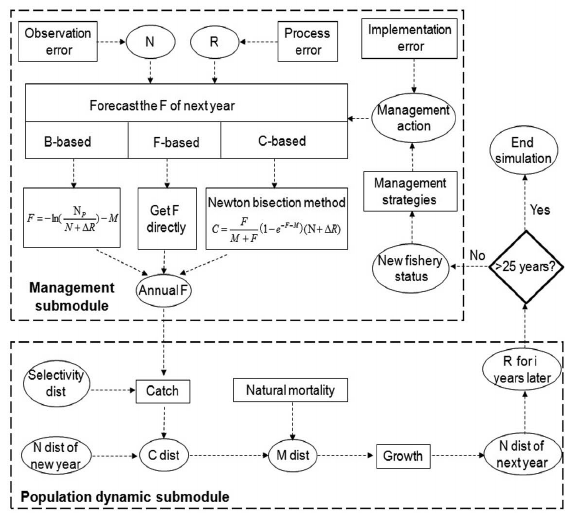
Fig . 1. – Flowchart of the simulation model.